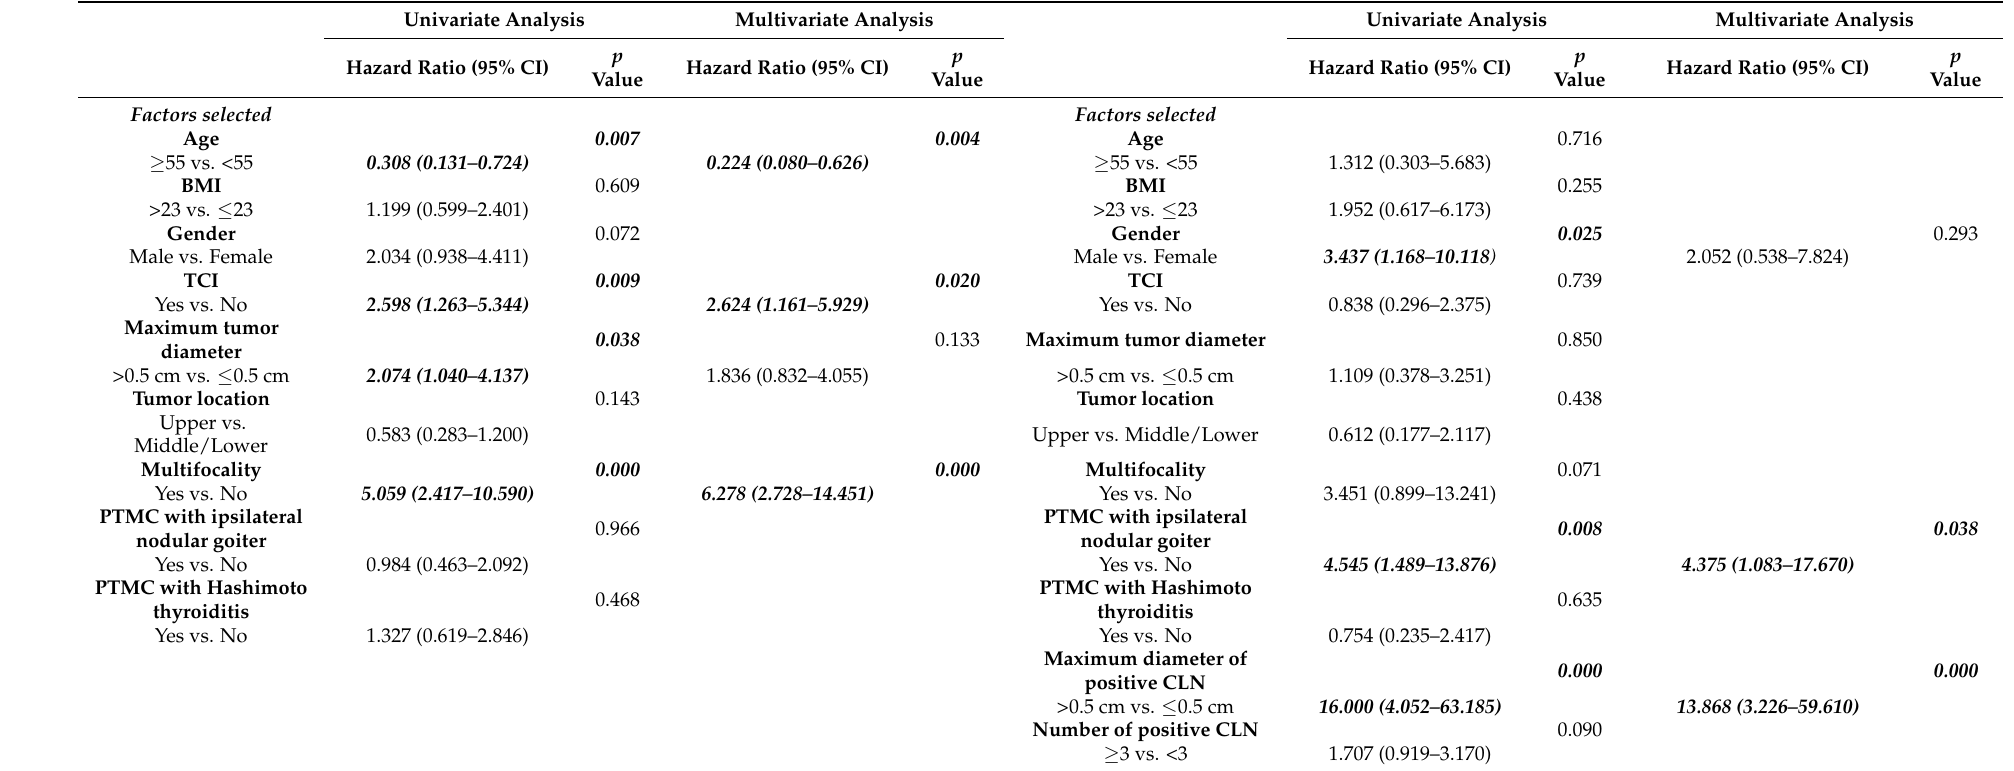
Table 4. Univariate and multivariate analyses for PTMC patients with bilateral